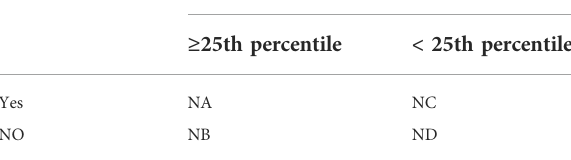
TABLE 1 Accuracy index